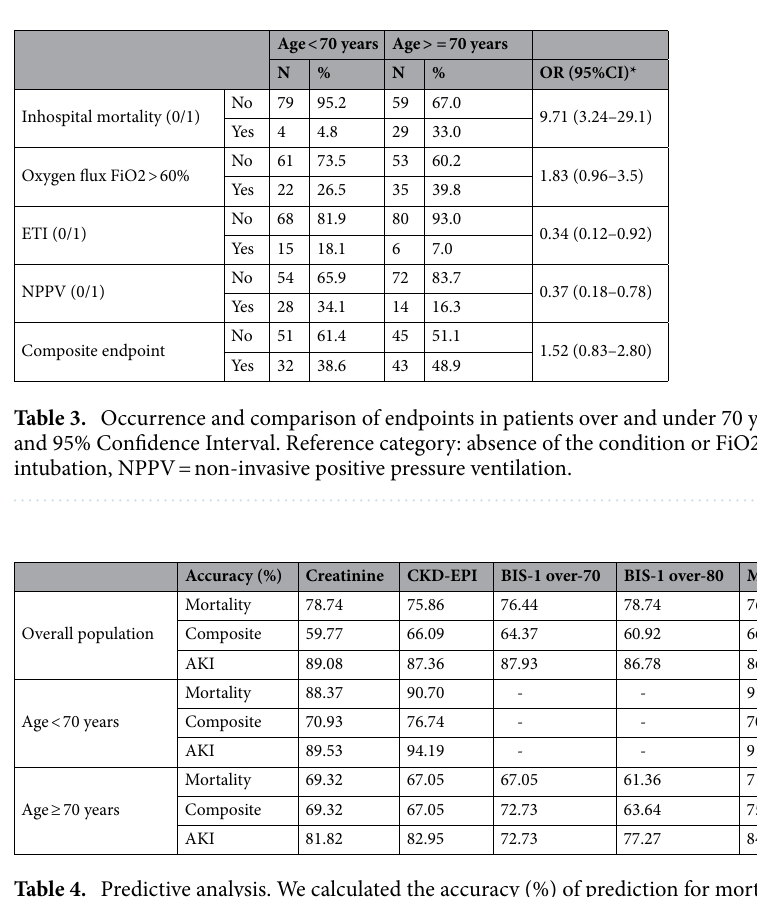
Table 4. Predictive analysis. We calculated the accuracy (%) of prediction for mortality, composite endpoint and AKI using only a single indicator of kidney functionality (serum creatinine or a specific eGFR) together with the other variables, in the overall population, in the population with age < 70 years, and in the population with age ≥ 70 years. The other predictors or variables are age, blood urea nitrogen, comorbidities, leucocytes, neutrophils, and lymphocytes count, LDH, PCR, ferritin, procalcitonin,